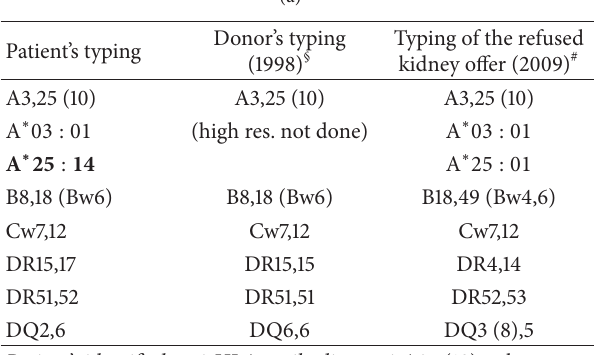
Table 3: (a) HLA typing results of the patient, his donor from 1998, and a refused kidney offer from 2009. Identifiable HLA- specific antibodies and crossmatch-ELISA results of the patient are presented. (b) AbCross-crossmatch-ELISA results using three sera of the patient (taken in 06/2009, 07/2011, and 12/2012) which were tested for DSA against three selected stored leukocyte pellet lysates of virtual donors bearing the allele HLA-A ∗